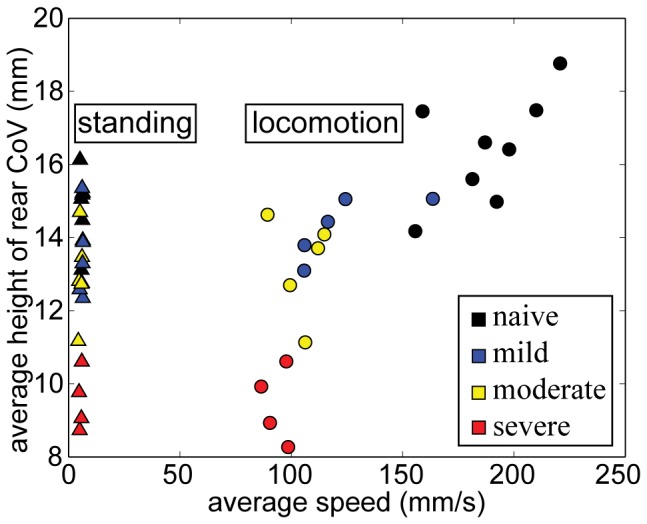
Average rear CoV height vs. average speed during standing and locomotion faster than 60/s.Both directed and exploratory locomotion are included in these data, as long as the animal’s speed was faster than 60 mm/s. Considering speed and rear CoV height in combination distinguished naïve from moderate and severe SCI groups, and mild from severe SCI.